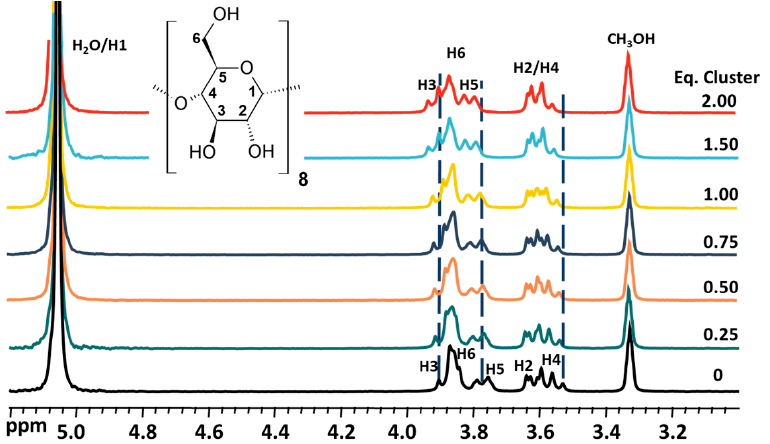
Figure 4. 1 H NMR spectra from the titration of 2mM γ -CD solution with the Mo 6 Cl 14 in D 2 O/CD 3 OD (50/50 vol.%) mixture with 5 vol.% of DCl conc